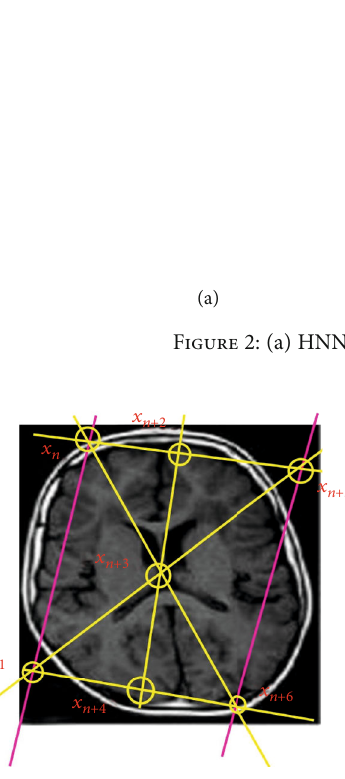
Figure 3: A visual of a geometric Lefshetz hyperplane in an